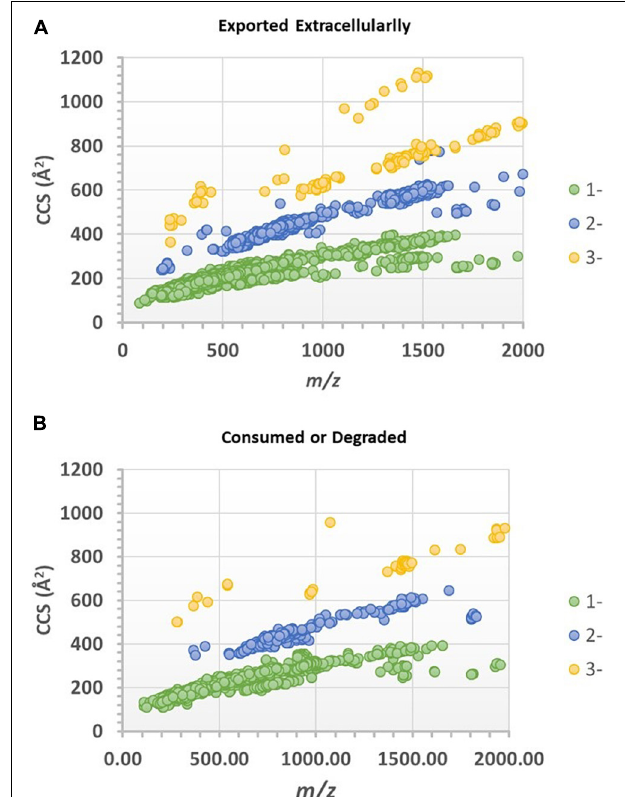
FIGURE 6 | CCS- mz plots of the spectral features (ions) that are statistically significantly different between the experimental and control media. (A) Features or ions that were found higher in the experimental culture media (assumed exported extracellularly), or (B) higher in the cell-free control media (assumed consumed or degraded by extra-cellular